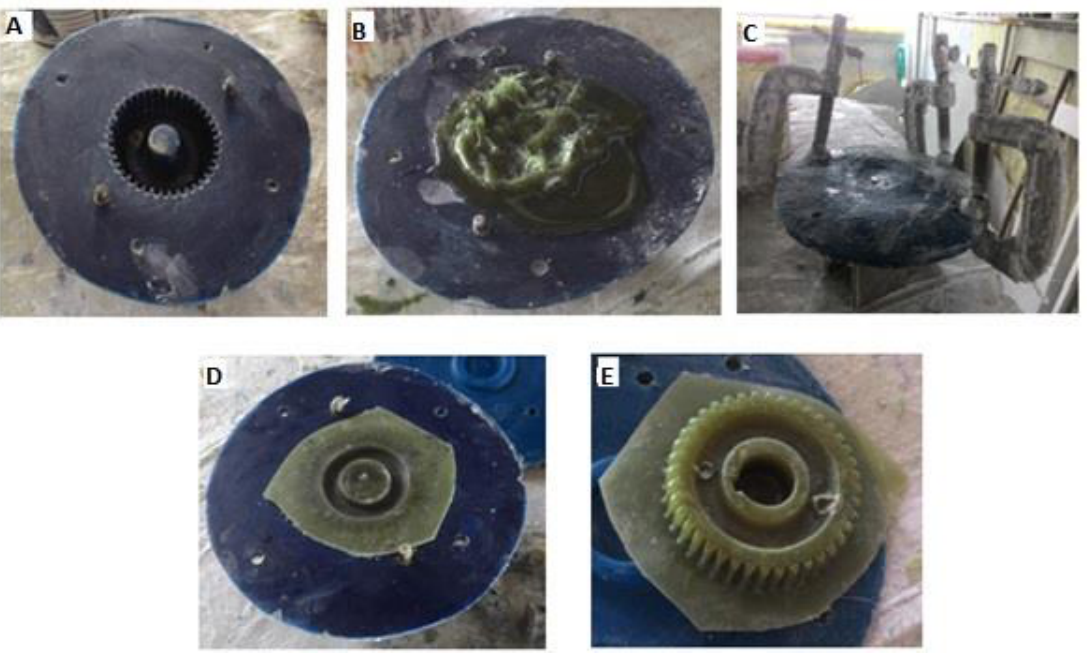
Figure 1. ( A ) Mold for gear. ( B ) Moldfilled with resin and fiber. ( C ) Mold compressed with c-clamp. ( D ) Product in the mold. ( E ) Final product.